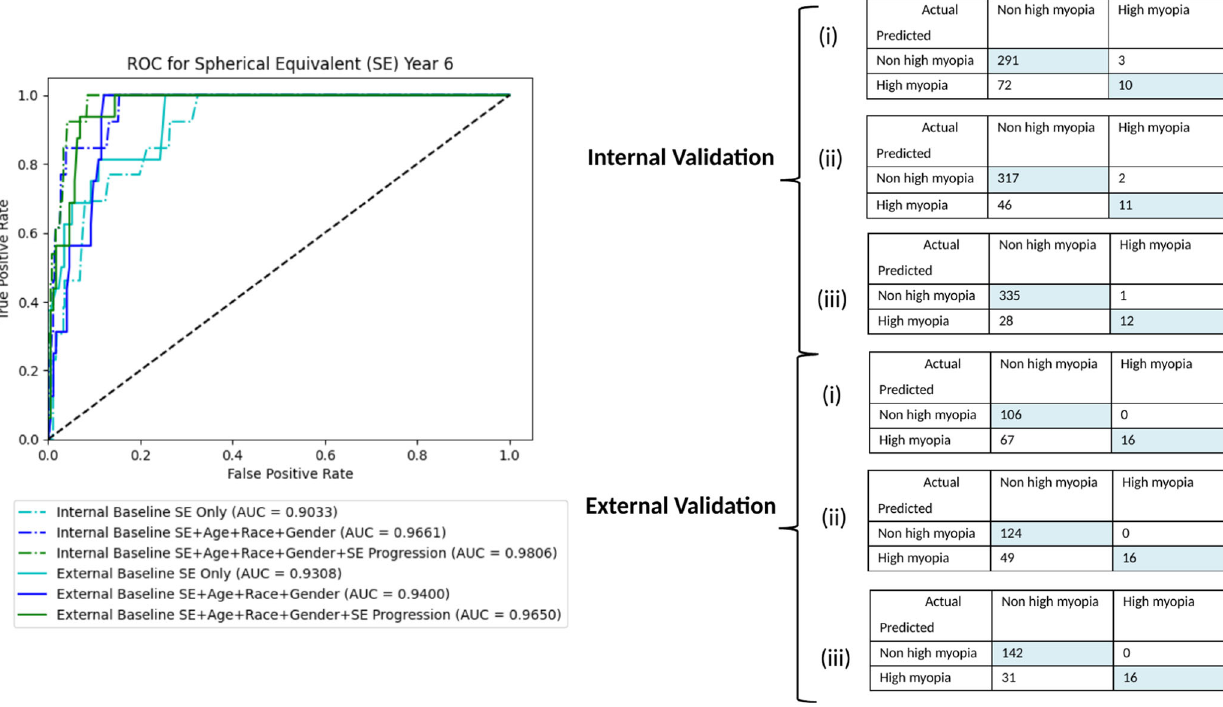
Fig. 2 Performance of clinical models. AUC and confusion matrixes for internal and external validation of clinical models – (i) Baseline SE, (ii) Baseline SE + Age + Race + Gender, and (iii) Baseline SE + Age + Race + Gender + 1-year SE models were developed for (i) Fundus photo + Baseline SE and (ii) Fundus photo + Age + Race + Gender + Baseline SE with AUC The algorithm with baseline childhood fundus imaging together and accuracy in classi fi cation of 0.97, 0.93 and 0.97 – 0.98, 0.82 for with clinical data input achieved the highest performance in internal and external validation, respectively. The addition of prediction of high myopia in teenagers. Two baseline mixed